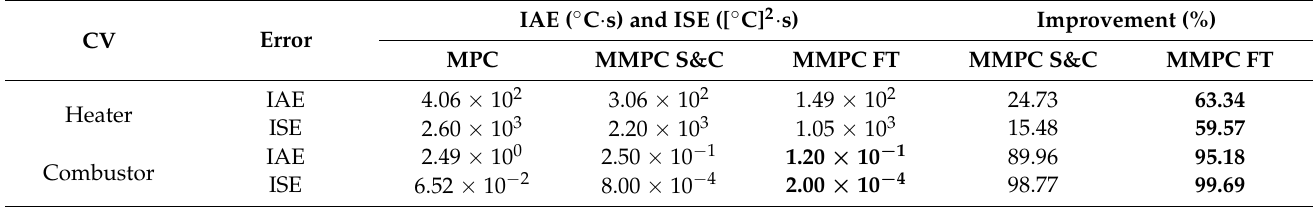
Table 16. Comparison of IAE and ISE on the heater and combustor units due to changes in SP on the combustor unit.